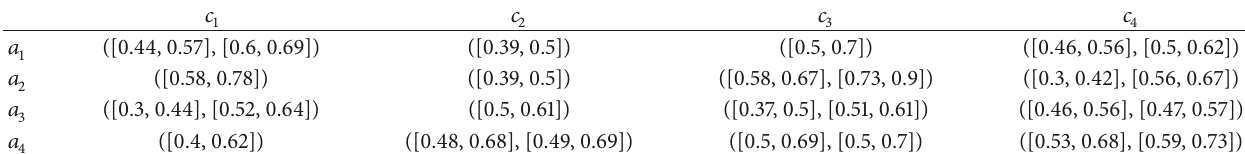
Table 8: The comprehensive interval-valued hesitant fuzzy matrix 𝐻